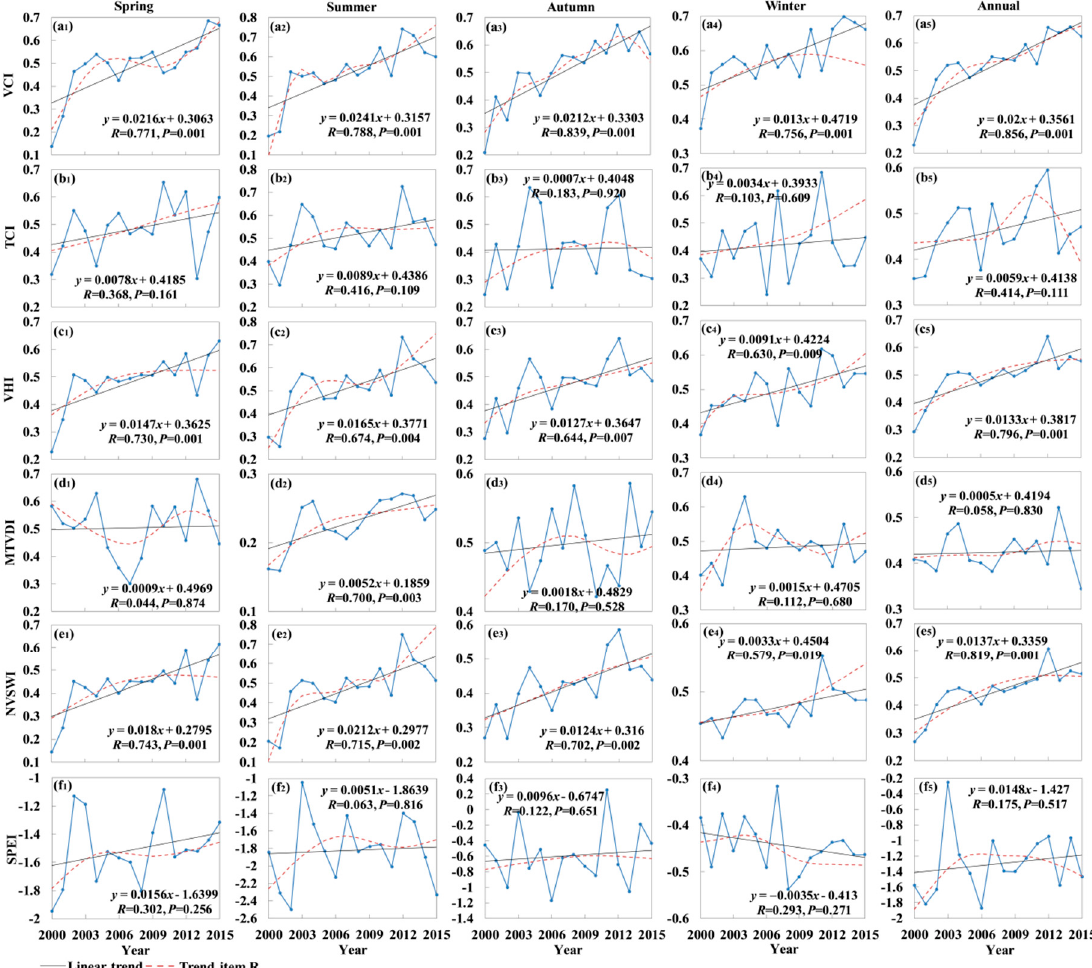
Figure 5. Characteristics of drought in the Yellow River basin (YRB) during 2000–2015.